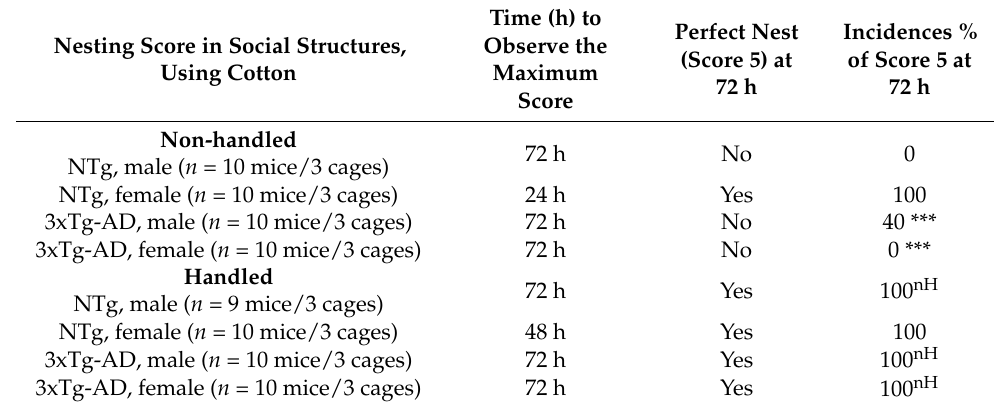
Table 1. Long-term effects of early postnatal handling on home-cage-based social nests built by male and female six-month-old NTg and 3xTg-AD mice. Nesting Score in Social Structures, Using Cotton